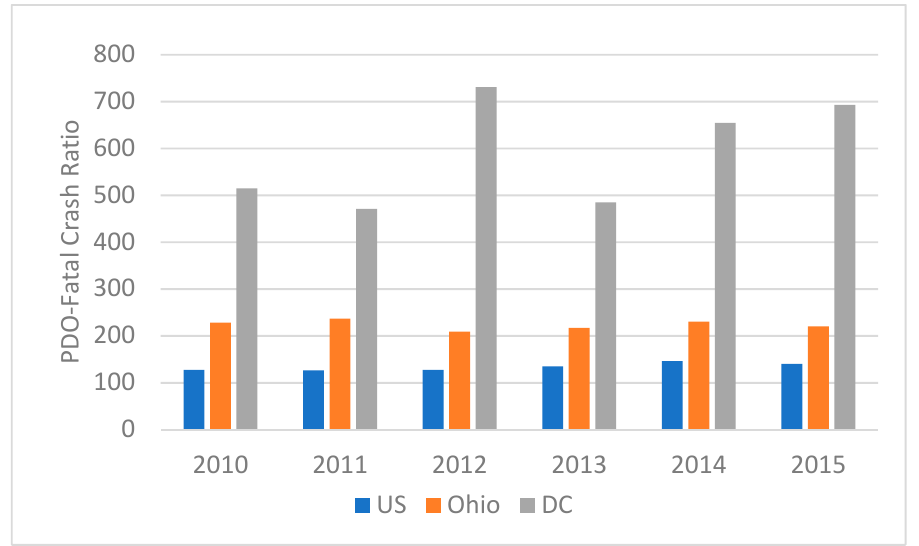
Figure 10. Crash severity relationship: Heinrich’s Triangle.